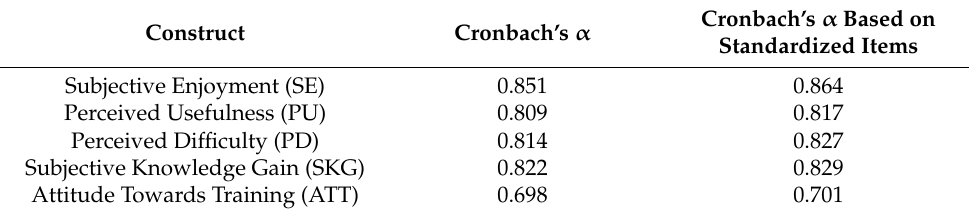
Table A5. The Cronbach’s alpha reliability of the Training Evaluation Inventory (TEI, seventeen